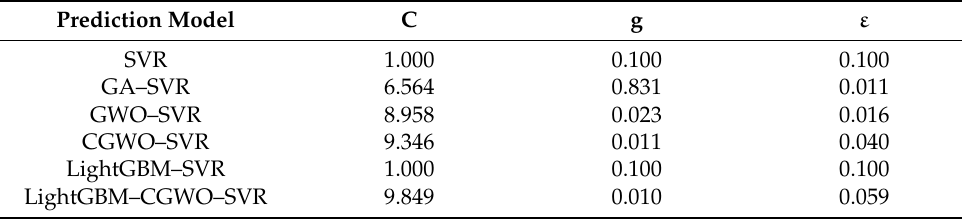
Table 3. Parameters of different SVR models in experiment.